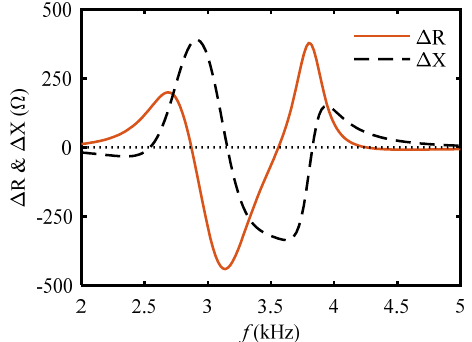
Figure 5. Impedance difference with and without baffle.